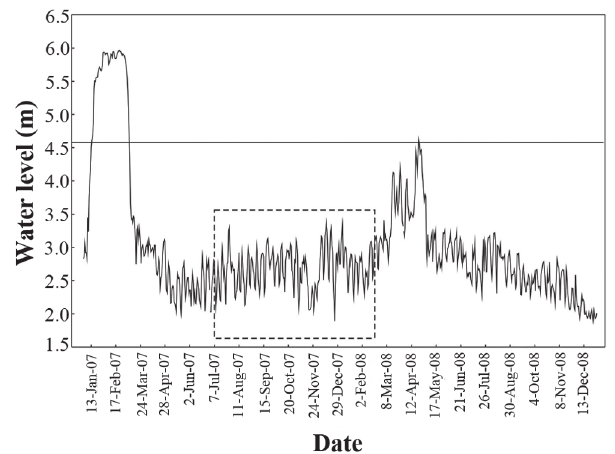
Fig. 2. Daily variation in river levels during sampling period. Horizontal lines show the threshold of the water level for river bank overflow (4.51 m Paraná and Baía Rivers, Fernandes et al. , 2009). The square notes the water level of the sampling